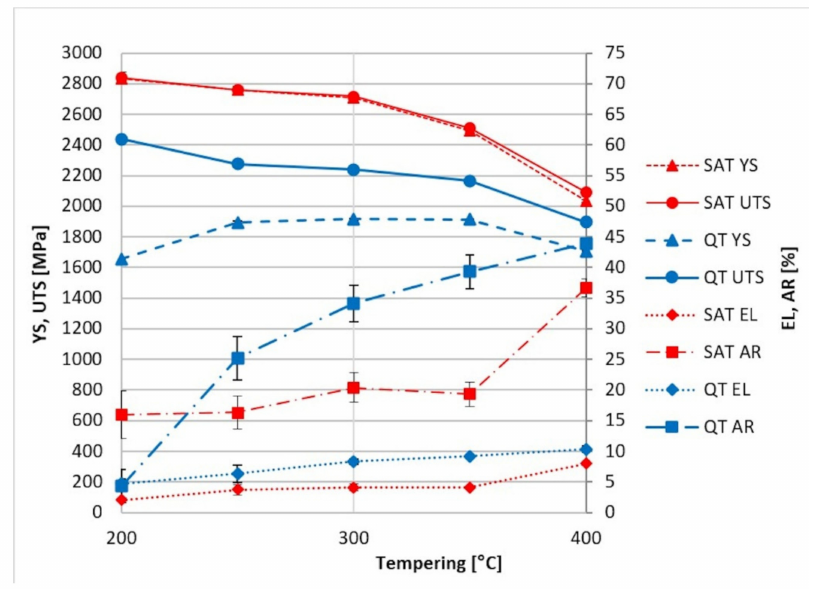
Figure 3. Comparison of tensile testing results from conventional QT (blue) and SAT processing (red).